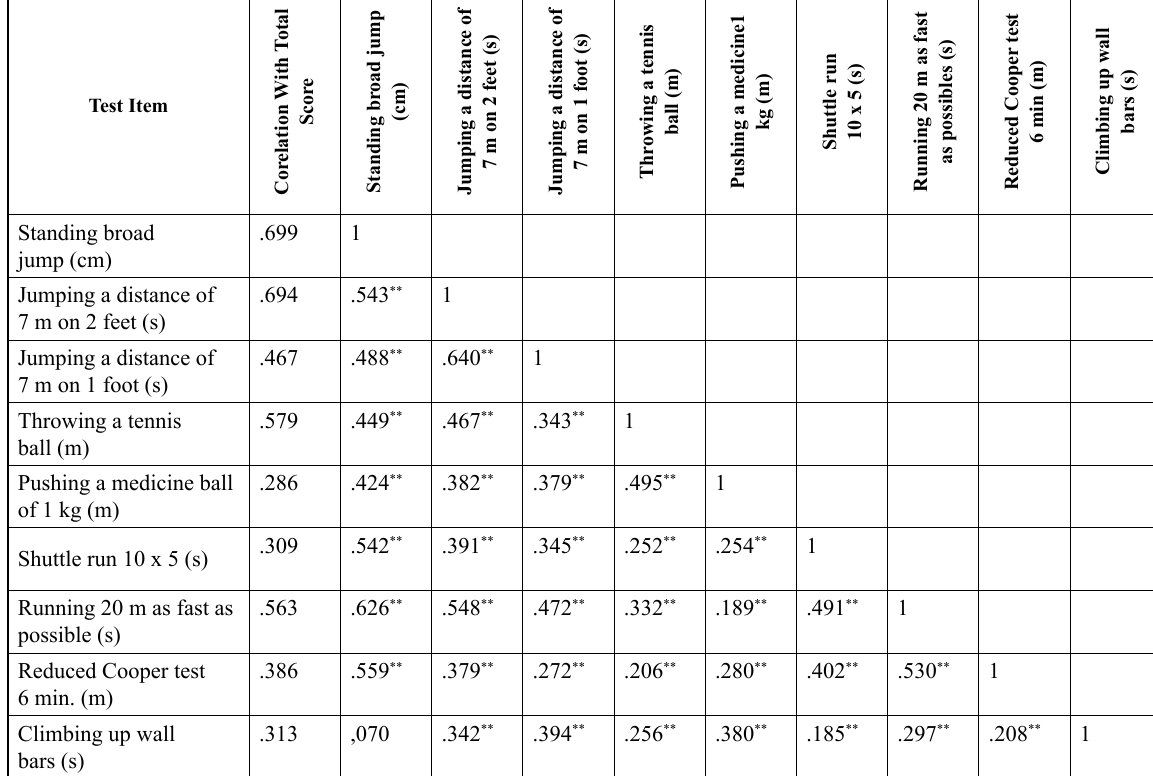
Note. ** – correlation is significant at the .01 level